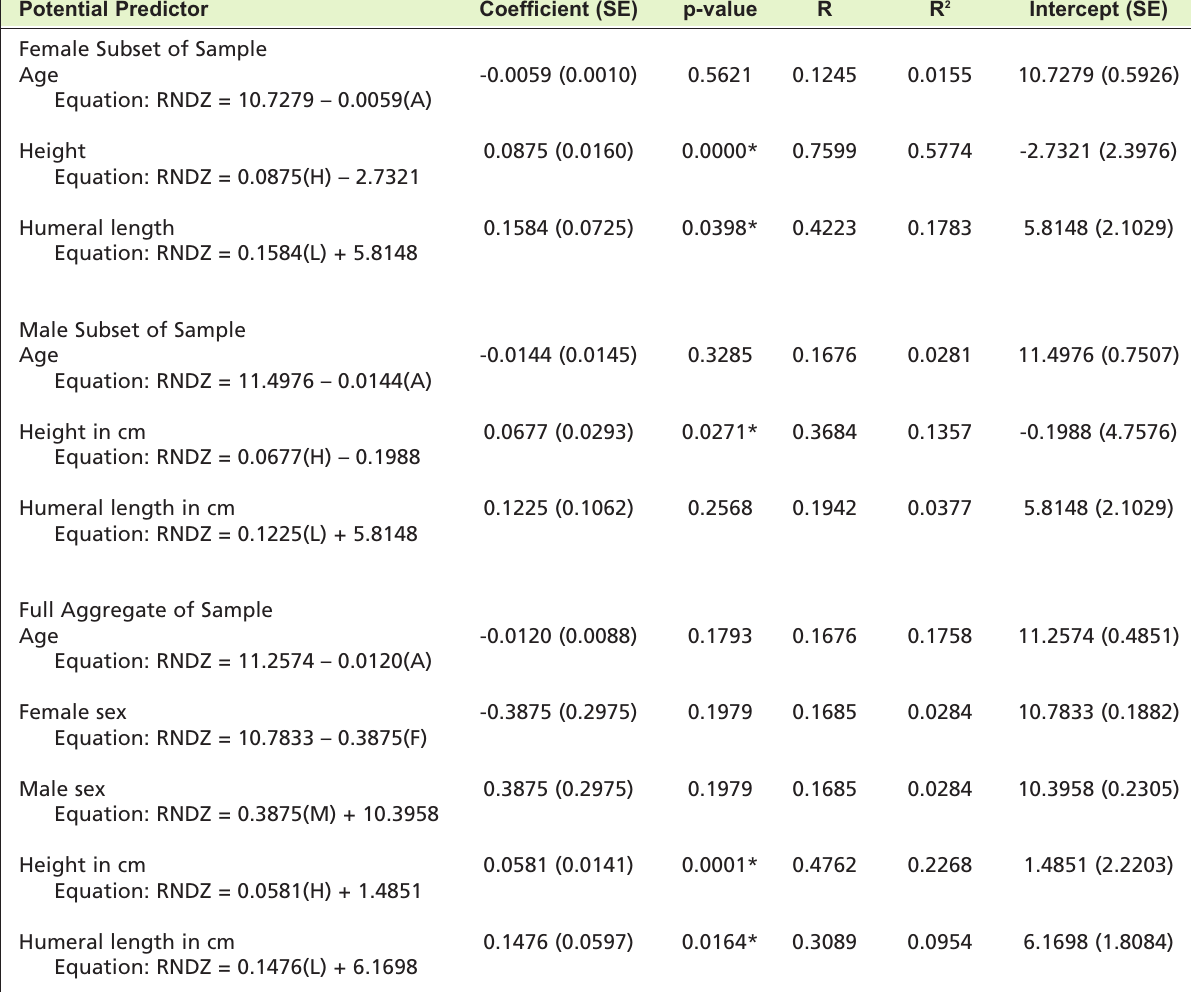
sample of cadavers